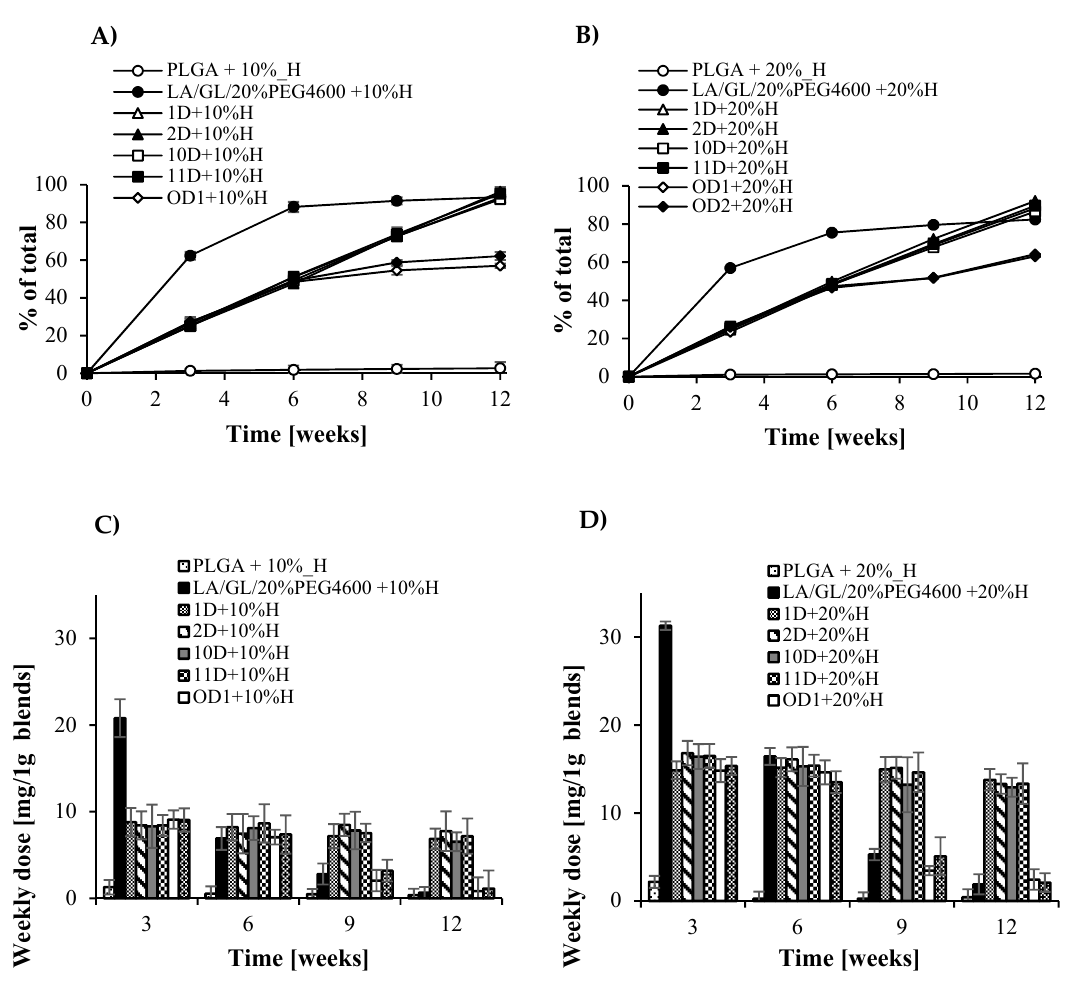
Figure 7. Cumulative ( A,B ) and weekly dose release ( C,D ) of metazachlor in soil (dextrin).